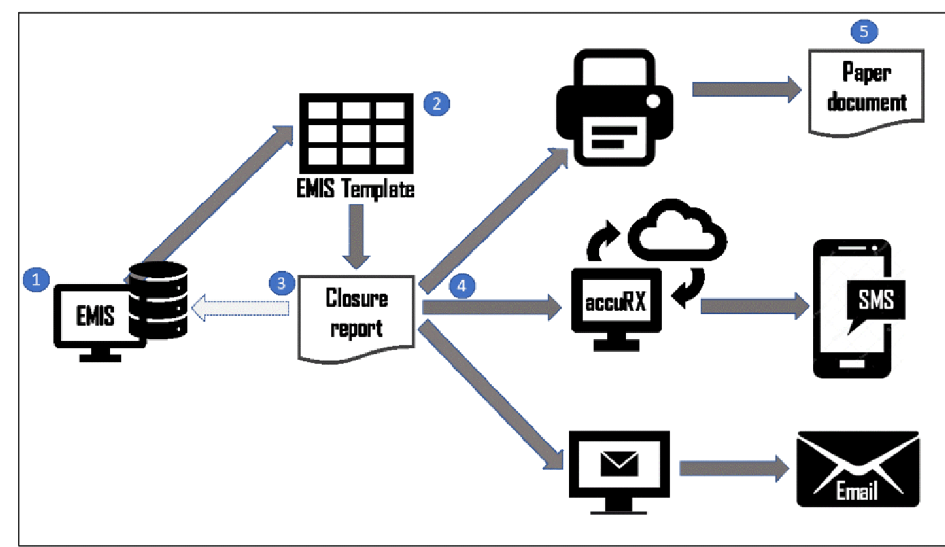
Figure 11. Consultation summary report generation: process